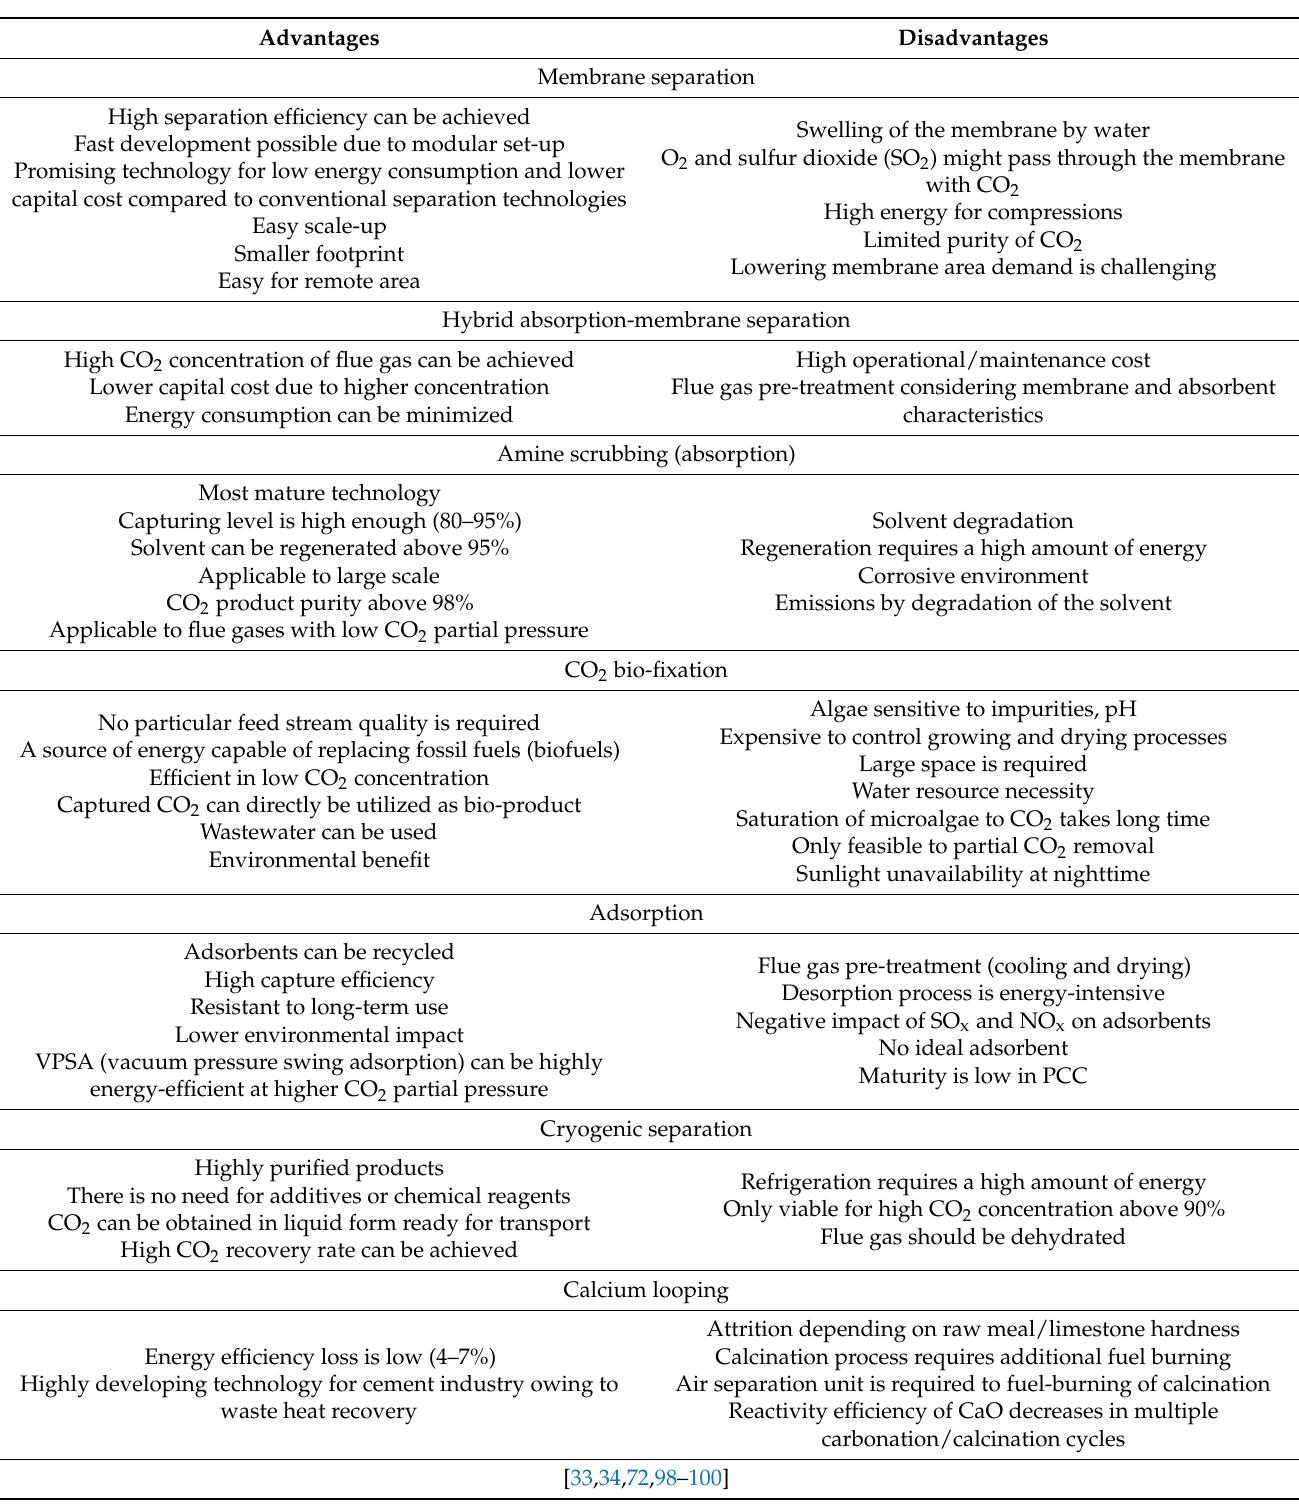
Table 3. Overall advantages and disadvantages of CO 2 capture